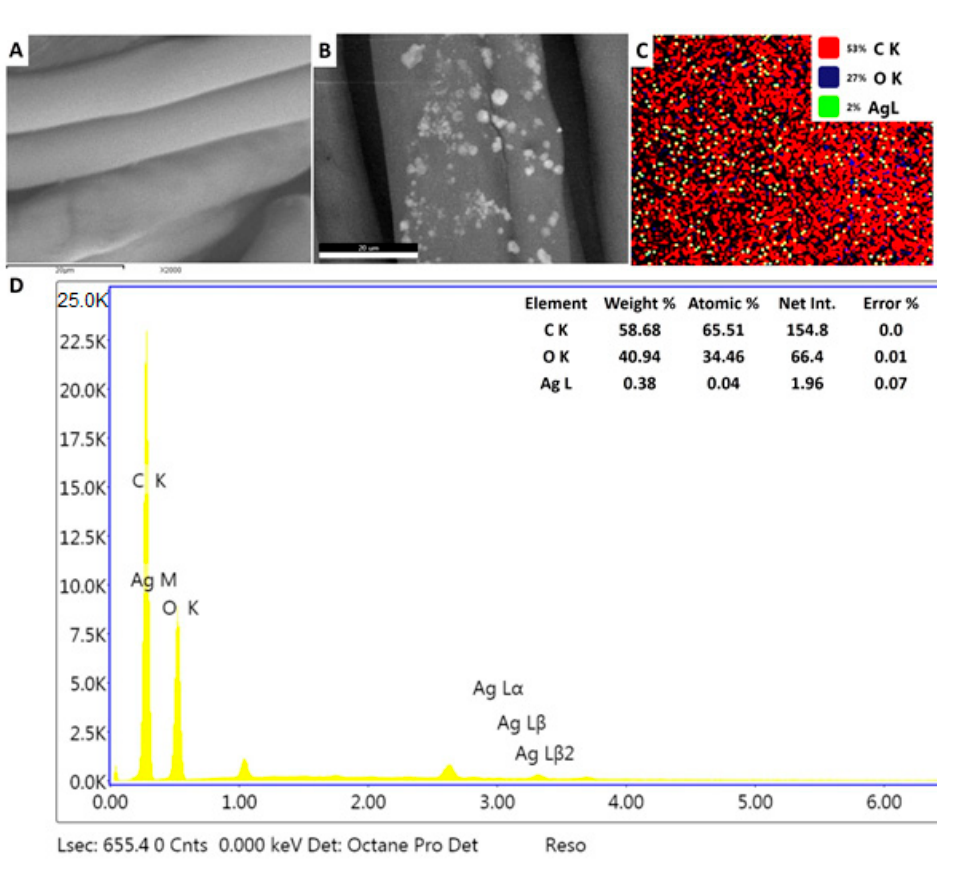
Figure 7. Scanning electron microscopy results for cotton fabrics; ( A ) cotton fabric without any treatment, and showing smooth surface; ( B ) cotton fabrics treated with Ag-NPs (100 ppm), showing the deposited NPs on the cotton surface; ( C ) mapping picture of treated fabrics with Ag-NPs, showing qualitative elemental analysis; ( D ) EDX of the treated sample with elemental analysis of the Ag-NPs contents.